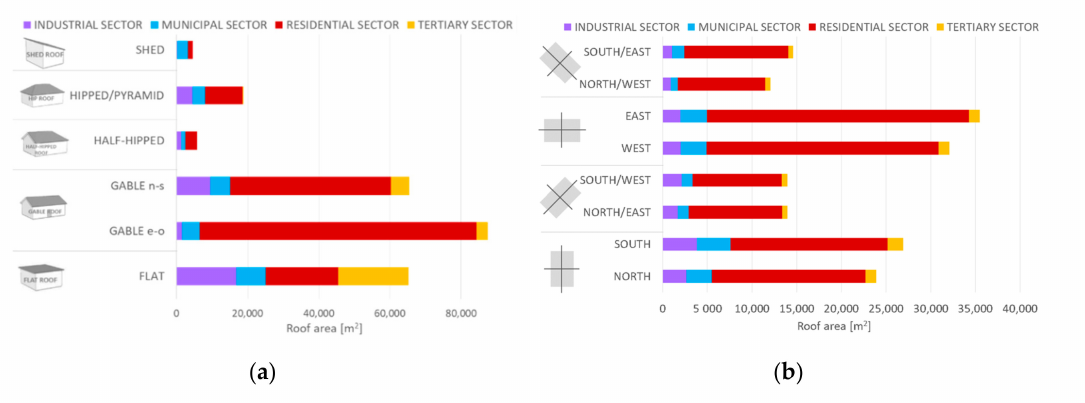
Figure 3. District of Turin with a dimension of 1 km 2 : ( a ) Roof typology analysis and roof area; ( b ) building orientation analysis and roof